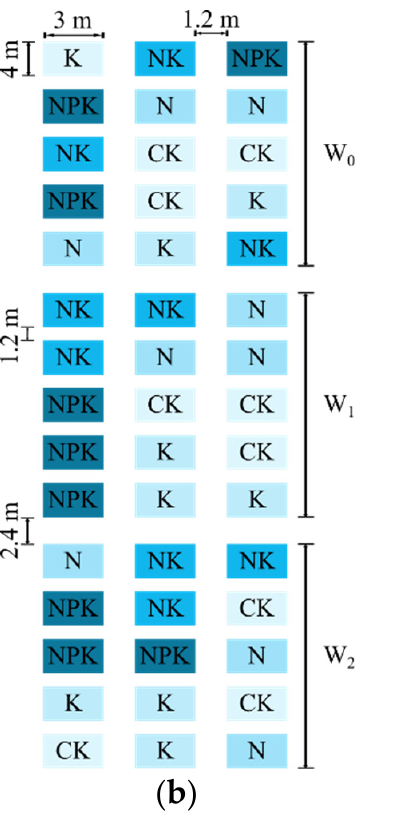
Figure 2. Distribution of the experimental plots. ( a ) Overview of experimental field in 2020; ( b ) Fertil- ization and irrigation treatments in 2020; ( c ) Overview of experimental field in 2021; ( d ) Fertilization and irrigation treatments in